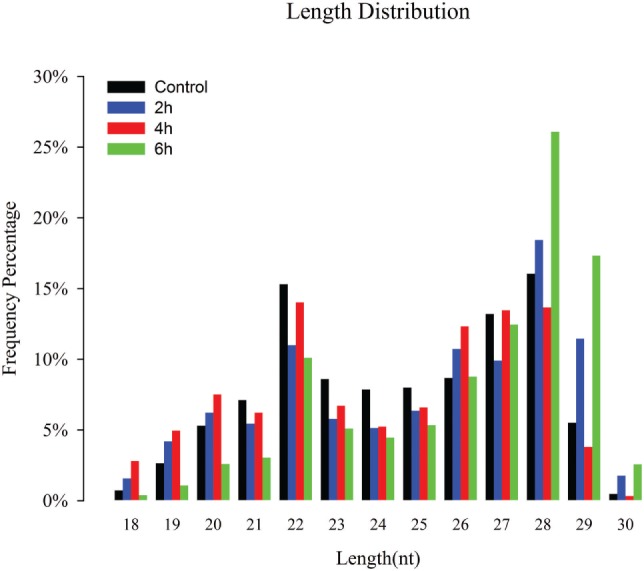
Size distribution of destruxin A-responsive small RNAs (sRNAs) in the libraries of Plutella xylostella. Different colors represent different libraries. x-Axis represents sRNA length distribution and y-axis represents frequency percentage.